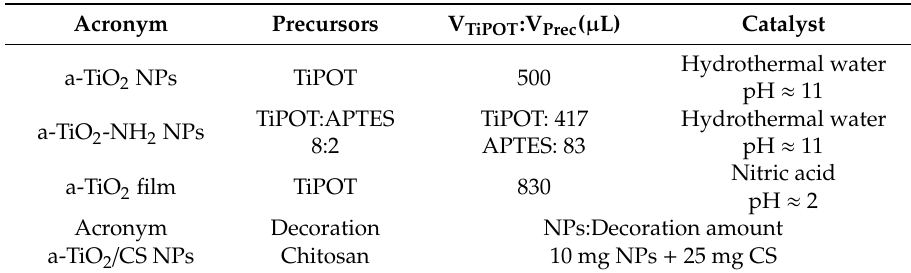
Table 1. Amorphous titania (a-TiO 2 )-based nanoparticles (NPs) and films acronyms, compositions, and sol-gel precursor’s volumes. CS-chitosan; APTES-3-aminopropyltriethoxysilane; TiPOT-titanium IV isopropoxide. Acronym Precursors V TiPOT :V Prec ( µ L) Catalyst Hydrothermal water a-TiO 2 NPs TiPOT 500 pH ≈ 11 TiPOT:APTES TiPOT: 417 Hydrothermal water a-TiO 2 -NH 2 NPs 8:2 APTES: 83 pH ≈ 11 Nitric acid a-TiO 2 film TiPOT 830 pH ≈ 2 Acronym Decoration NPs:Decoration amount a-TiO 2 / CS NPs